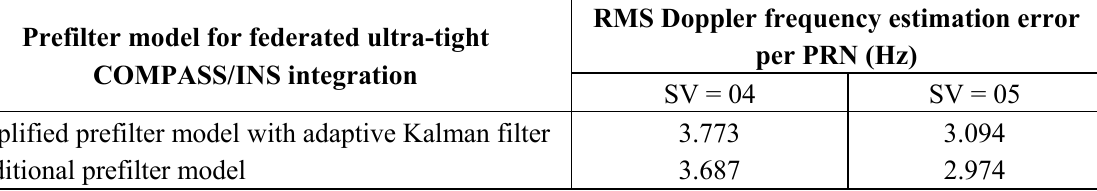
Table 3. RMS Doppler frequency errors of tracked SVs with different prefilter